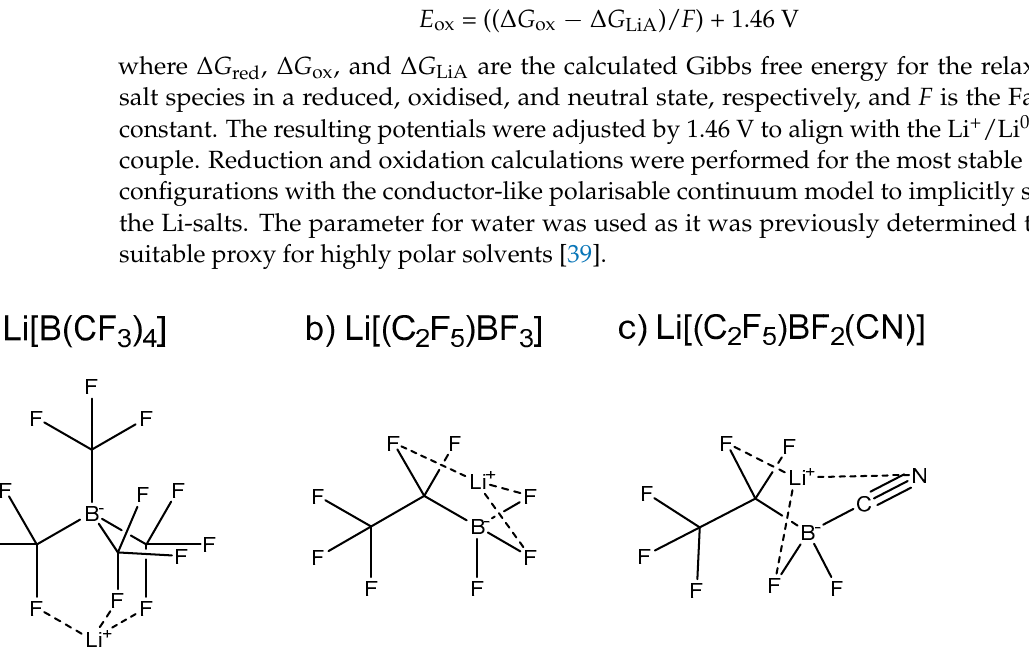
Figure 1. Borate anion-based Li-salts ( a ) lithium tetrakis(trifluoromethyl)borate (Li[B(CF 3 ) 4 ]), ( b ) lithium pentafluoroethyl- trifluoroborate (Li[(C 2 F 5 )BF 3 ]) and ( c ) pentafluoroethyldifluorocyanoborate (Li[(C 2 F 5 )BF 2 (CN)])investigated in this